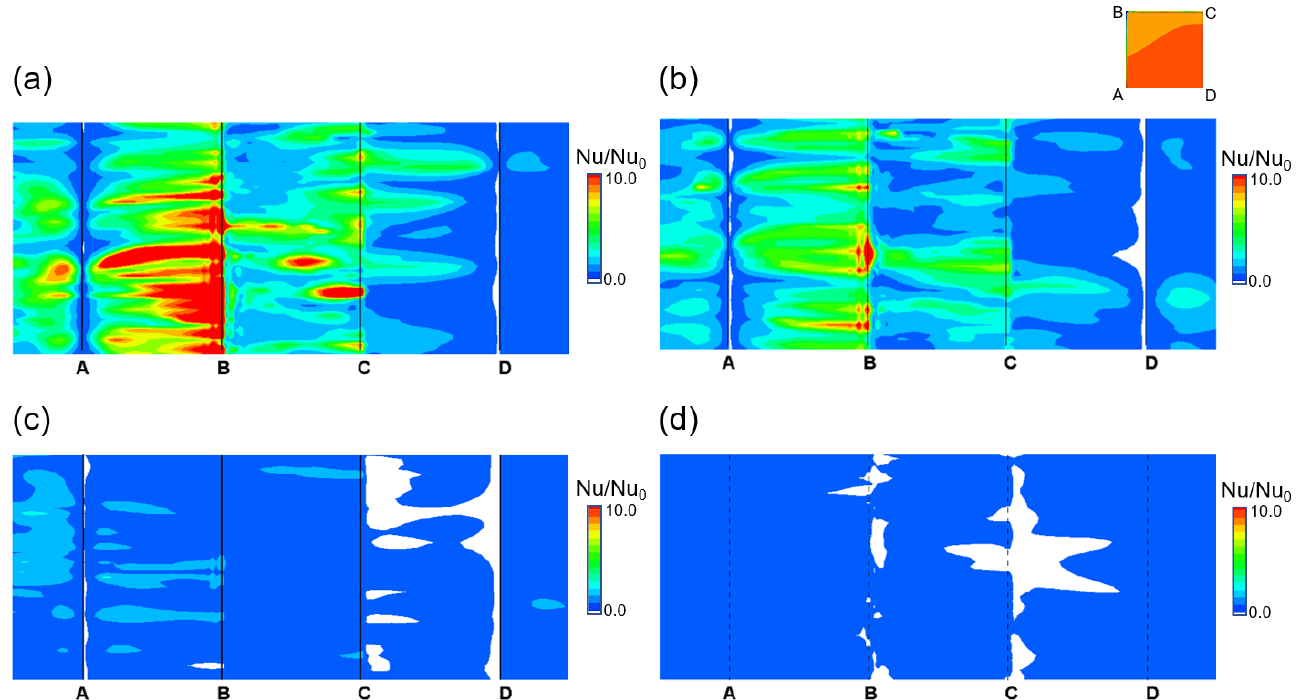
Figure 10. Instantaneous local heat transfer: ( a ) K* = 566.26; ( b ) K* = 100.0; ( c ) K* = 10.0; and ( d ) K* = 1.0.